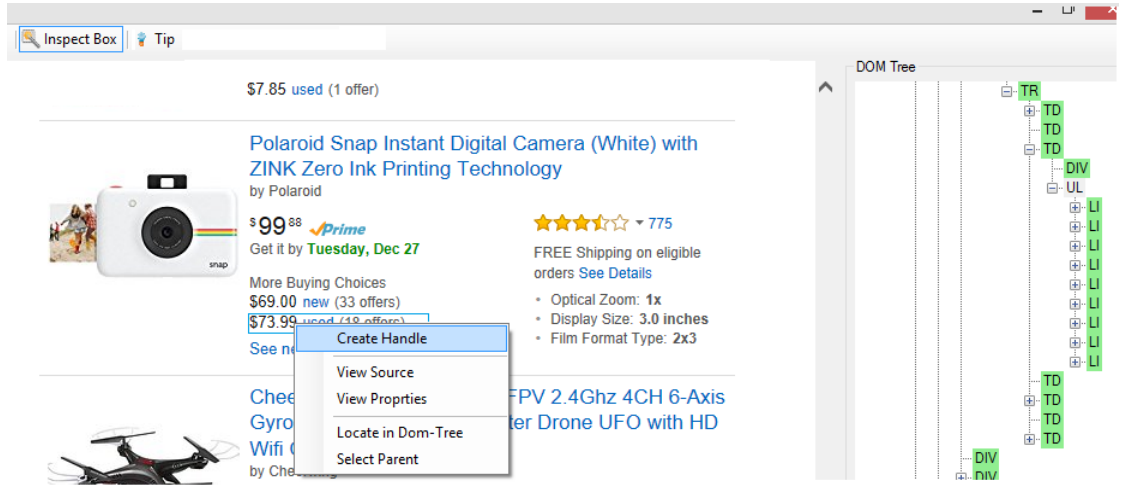
Figure 2. Identifying handles on a web page in our proposed system,